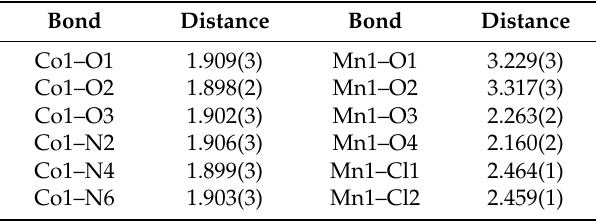
Table 2. Bond distances around the metal centers (Å).